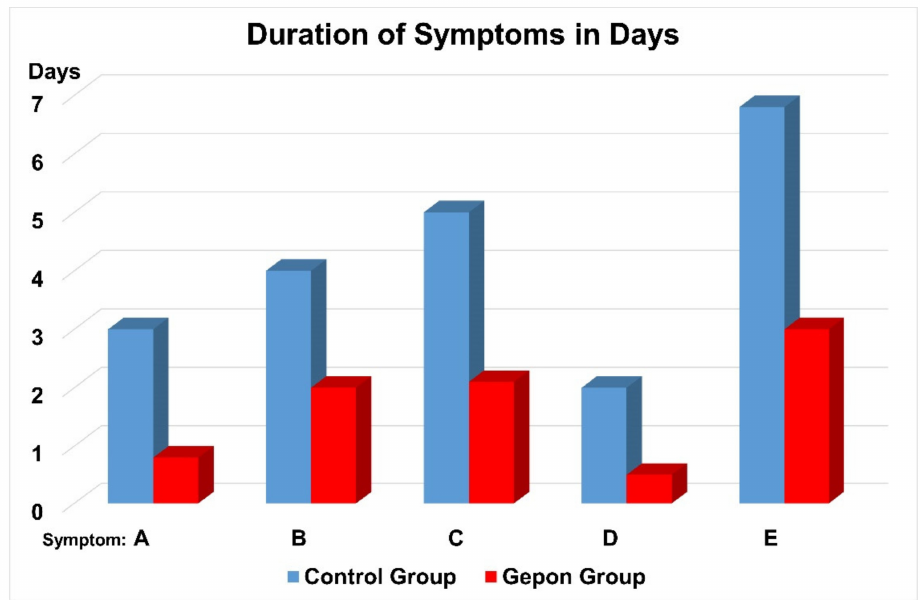
Figure 5. Three-month post-therapy follow-up. Control Group n = 50 (blue). Gepon group n = 50 (red). Duration of clinical symptoms in days (horizontal divisions). Symptom: A—Fever, B—Rhinitis, C—Wet-Cough, D—Antibiotics, E—AVRI. (drawn in